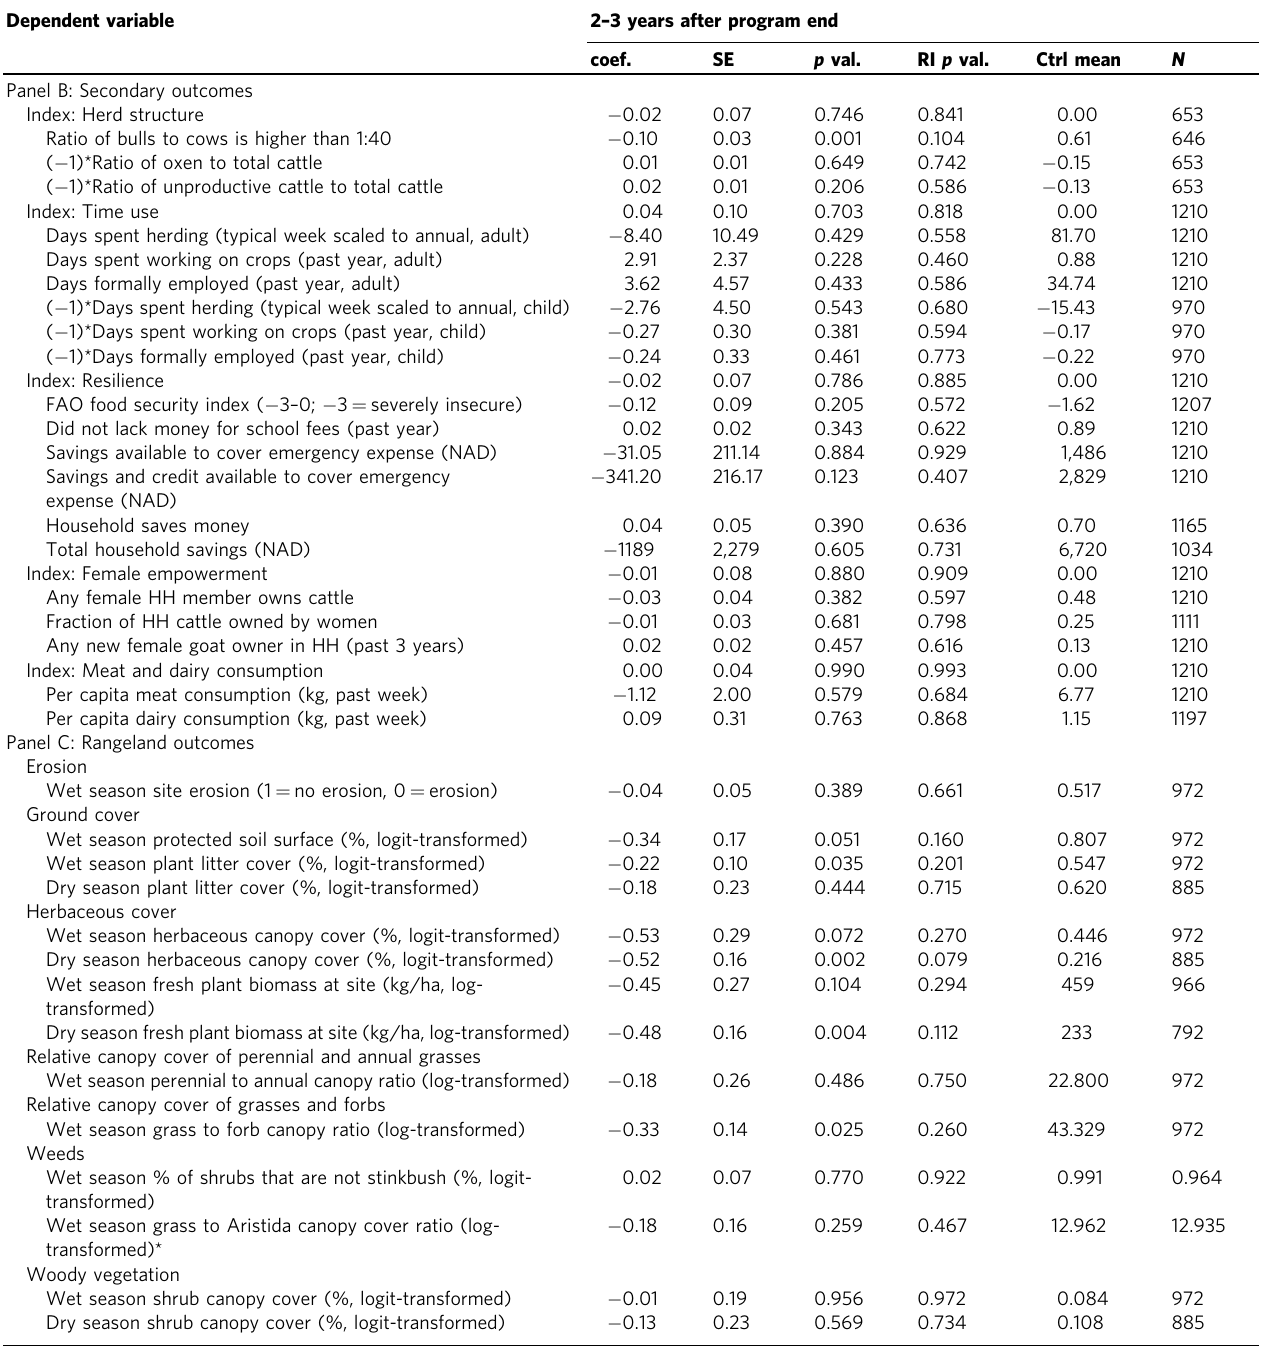
Table 6 Treatment effect on indices of rangeland health, cattle productivity and household economics, and their components (Panel B &